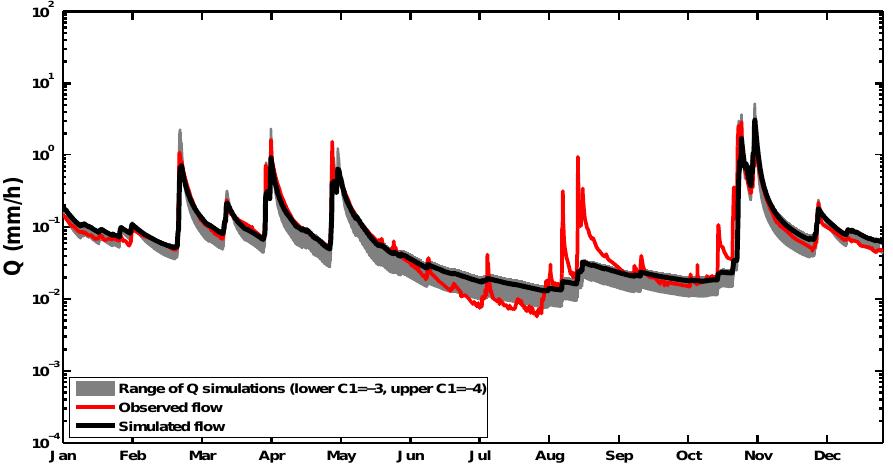
Figure 9. Observed versus simulated hydrograph ( C 1 = − 3 . 74) for the Ardèche at Meyras (#1) catchment (year 2004) with C 1 parameter variations ( C 2 and C 3 values are kept constant at 0.65 and − 0.2, respectively). The grey area shows the range of discharge